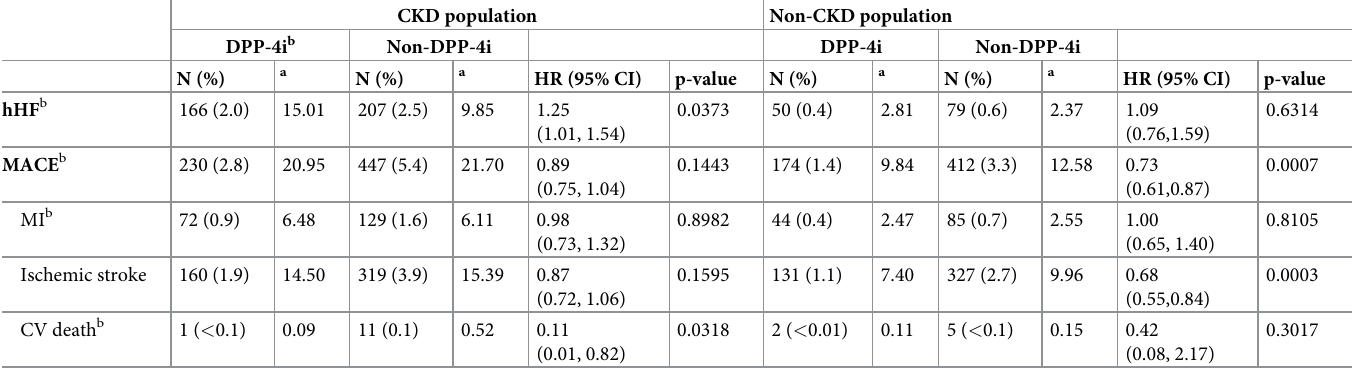
Table 2. Risks of hHF and